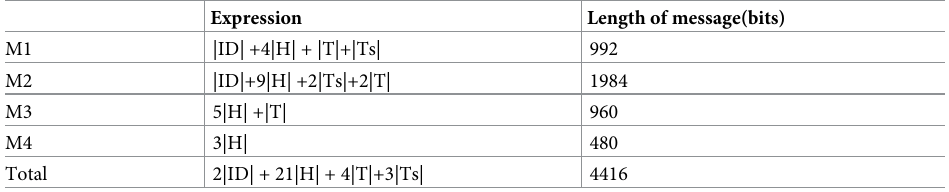
Table 5. Communication overhead of our proposed